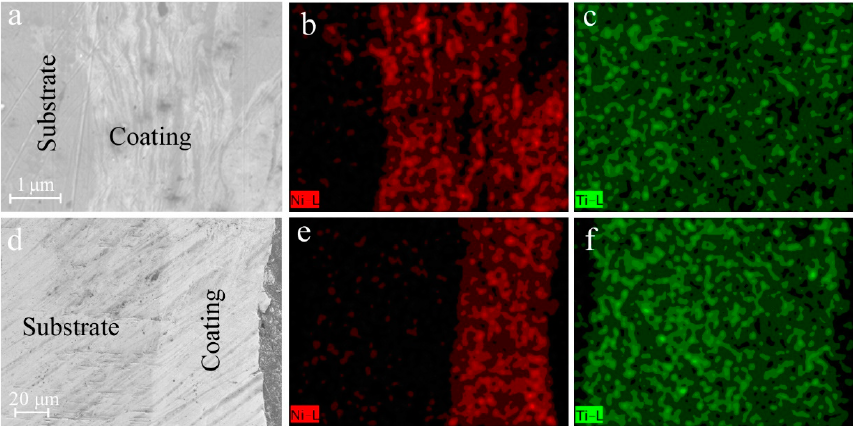
Figure 1. The XRD pattern of Ni-Ti coatings on Ti-based alloy substrate ( a ) after MA deposition, and ( b ) after laser treatment with the total energy per unit area of about 3.4 J/mm 2 .